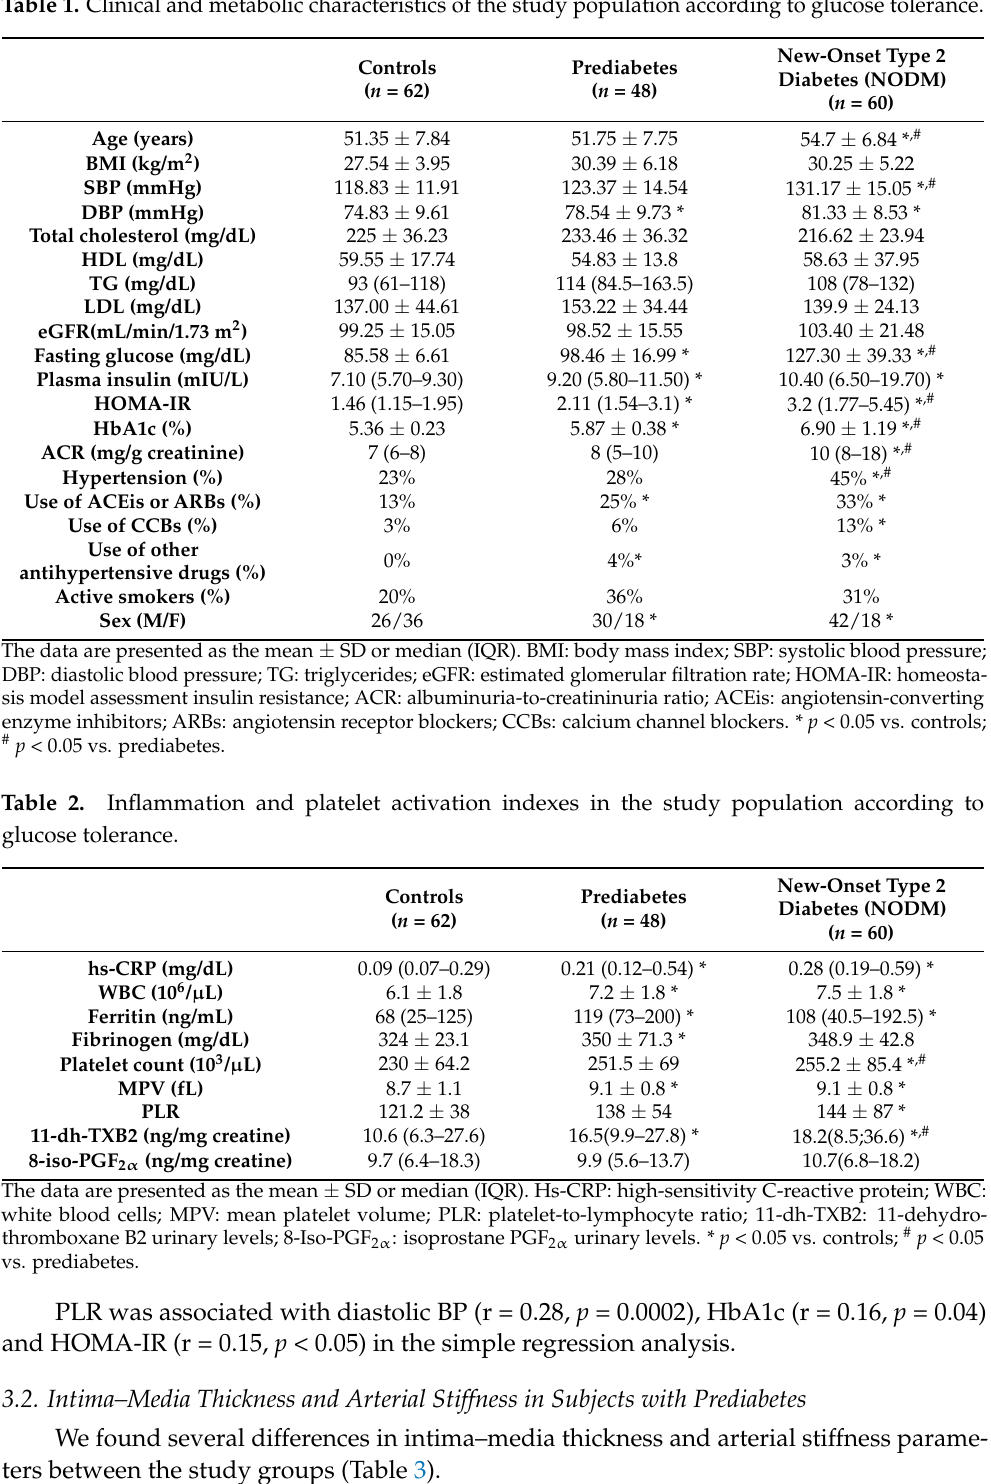
Table 1. Clinical and metabolic characteristics of the study population according to glucose tolerance.